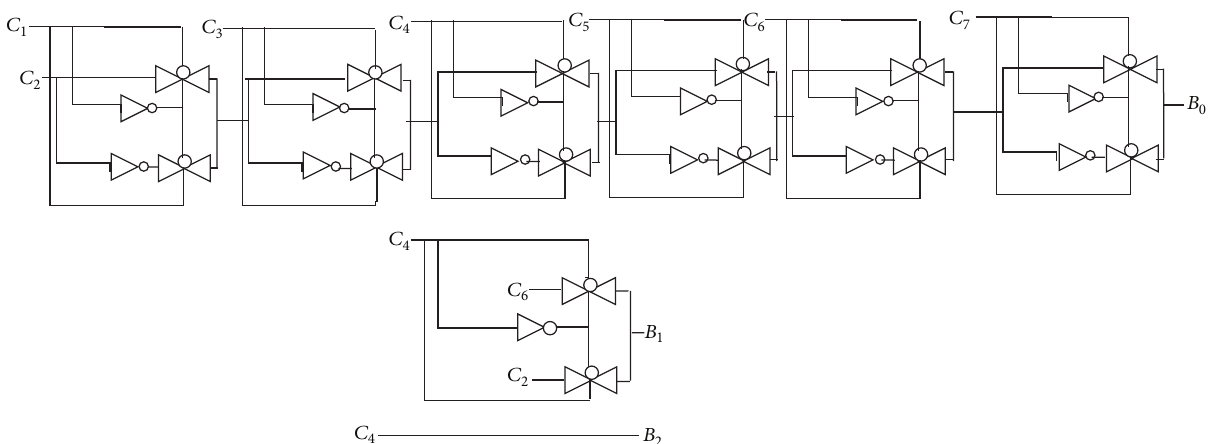
Figure 7: A 3-bit CM flash ADC.